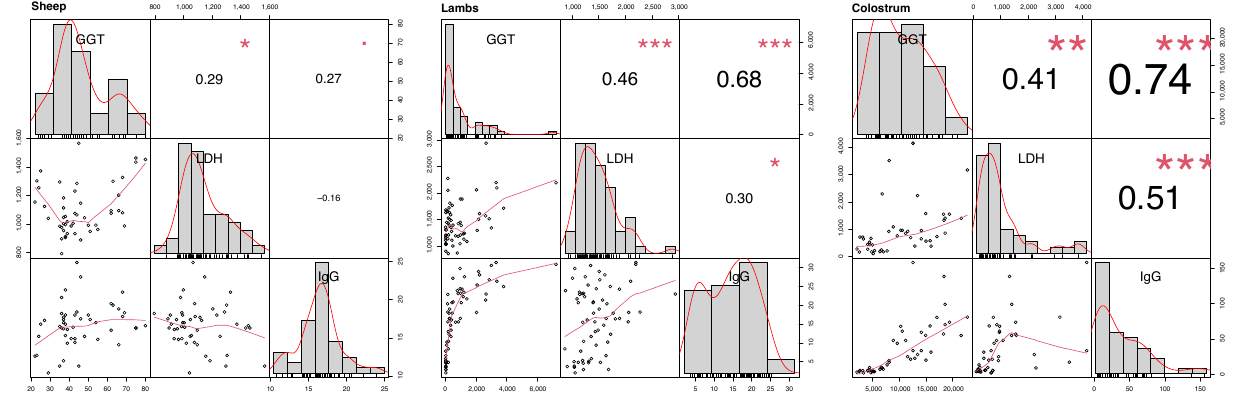
Figure 2. Correlation-chart IgG (g/L), GGT (UI/L), and LDH (UI/L) concentration in sheep and lambs blood serum and colostrum. The correlation value is represented for each pair of correlations. The asterisk indicates the significance level: <0.001 (***), <0.01 (**), <0.05 (*). The frequency distribution for each variable is represented by grey histograms, and their correlation by the plots on the left side of each group of